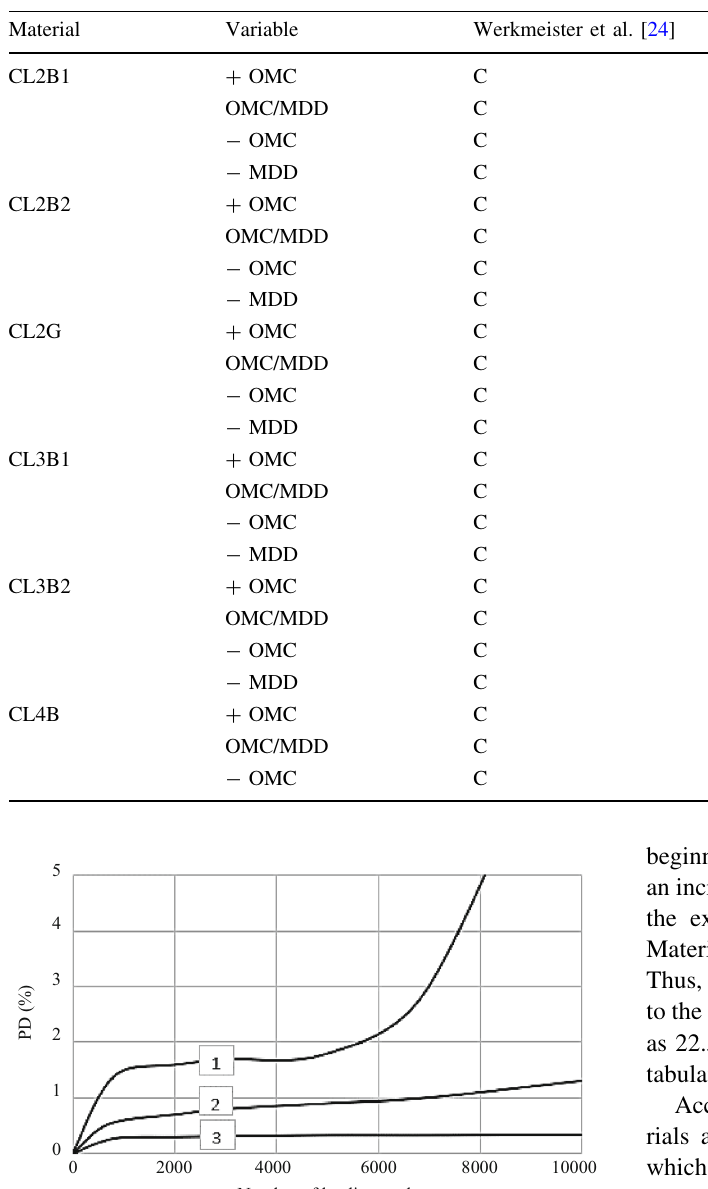
Table 7 Existing criteria for shakedown ranges Material